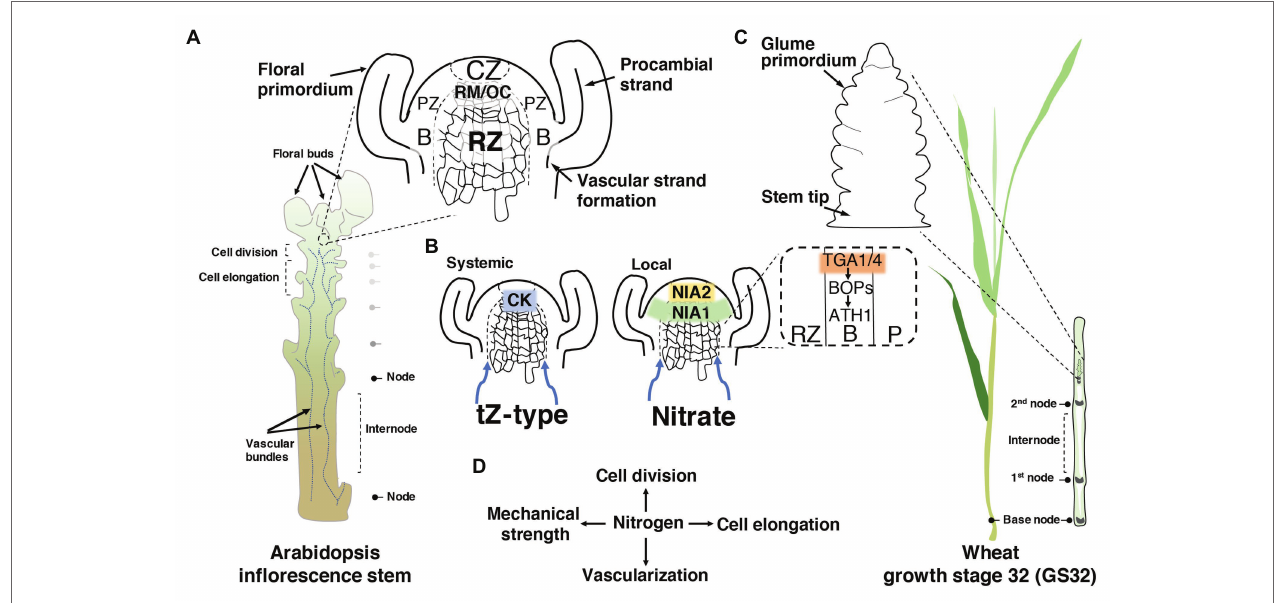
FIGURE 1 | How nitrogen (N) may modulate stem development. (A) Schematic illustration of Arabidopsis inflorescence stem showing the longitudinal section of the shoot apical meristem (SAM) and the meristematic zones. In detail, a representation of the oriented cell division in the rib zone (RZ). CZ, central zone; RM/OC, rib meristem/organizing centre; PZ, peripheral zone; B, organ boundary. (B) The dual nitrogen sensing within the shoot apex through a systemic root-to-shoot transport of the active cytokinin (CK) trans-zeatin (tZ), and the local sensing of nitrate through the nitrate reductase enzymes. In the dashed square, the two regulatory factors of the primary nitrate responses (TGA1/4) are highlighted, evidencing their involvement in the activation of the organ boundary genes. Blue arrows show the direction of root-to-shoot transportation. (C) Schematic illustration of wheat showing the growth stage 32 (GS32) based on Zadoks et al. (1974). In wheat, most N is taken up during the stem elongation phase (GS30–GS37) until the flowering stage. On the right, the longitudinal section of the nodes and internodes, and the floret initiation at this stage. (D) A simplified scheme of the central role of N in the regulation of the four different aspects of stem